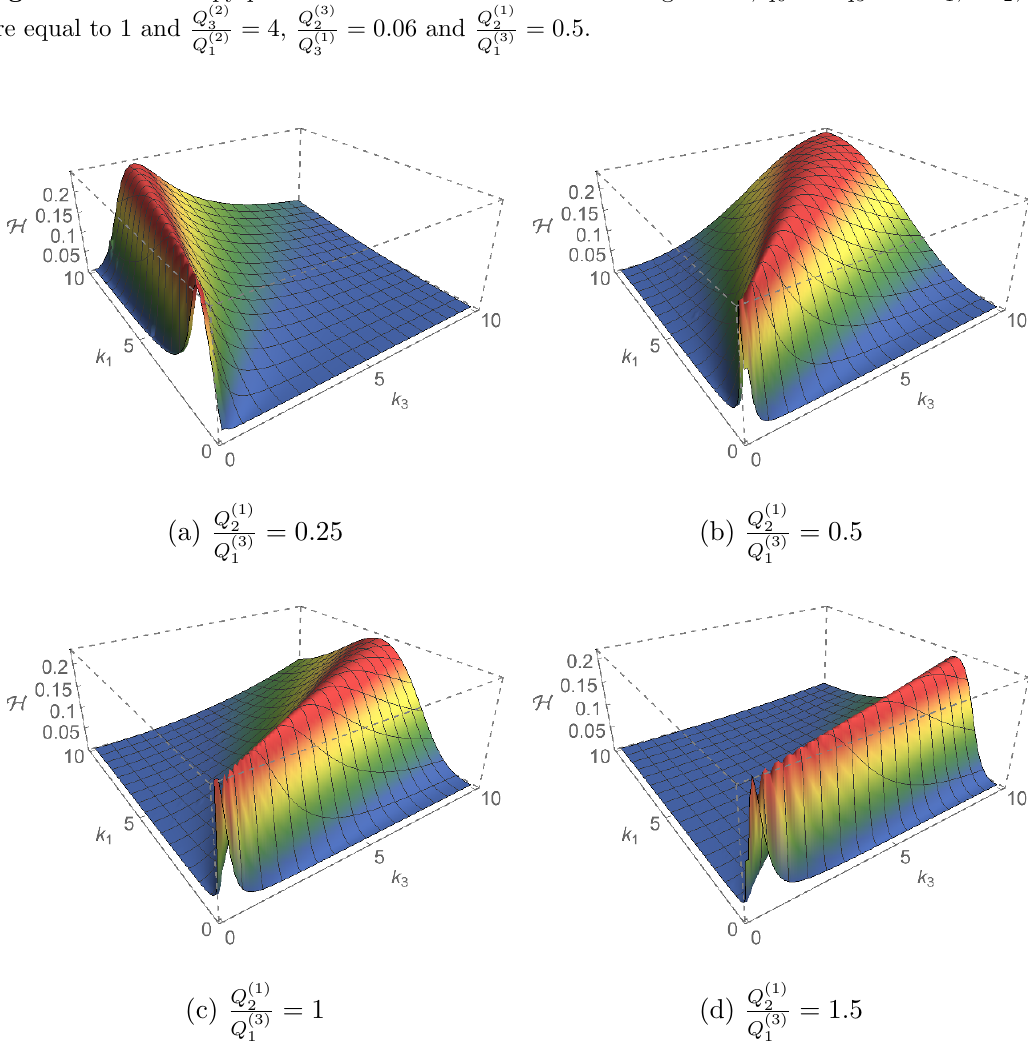
Figure 8 . The entropy parameter H as a function of the dipole charges k 1 and k 3 and one charge (1) ratio Q with q 0 , q 1 , q 2 equal to 1 and Q 2 Q (3) 1